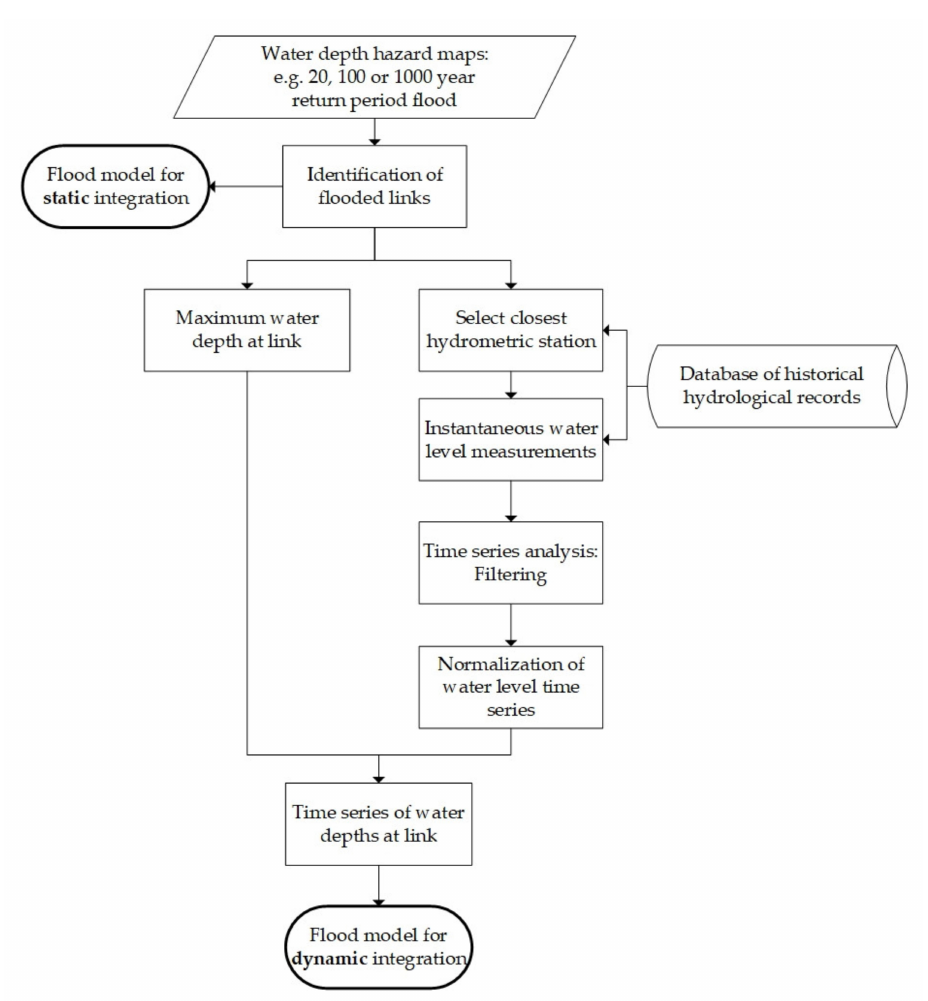
Figure 3. Methodology for producing flood models for static and dynamic